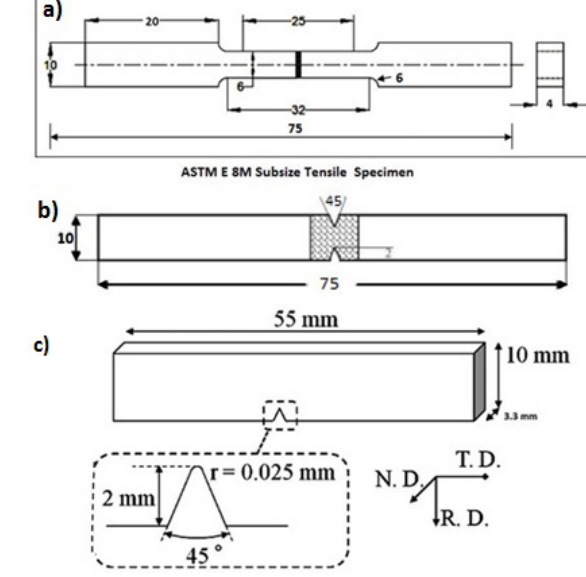
Figure 5: Dimensions of Test Specimens a) smooth tensile speci- men, b) notch tensile specimen and c) impact toughness